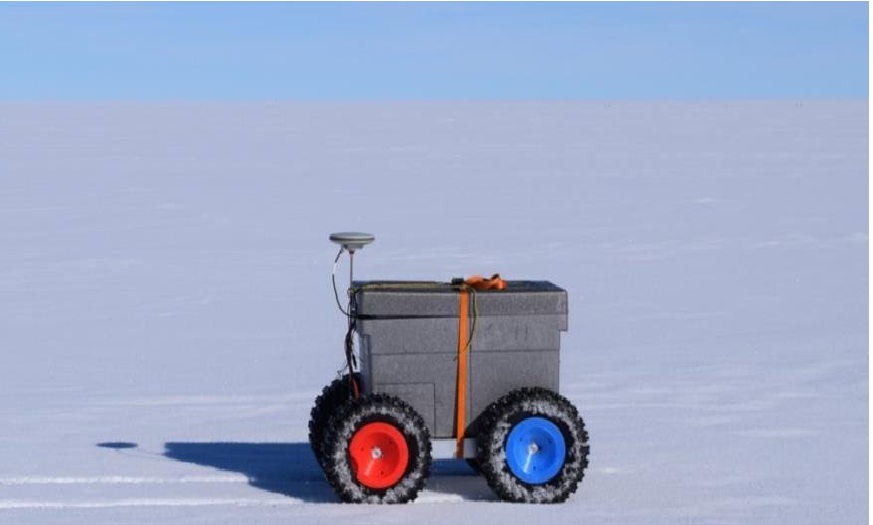
Figure 5. The ‘CIC’ rover is the type of platform that could be used with ice-penetrating radar for archaeological surveys to search for former bases that have been covered and associated equipment, such as aircraft within the ice (CIC